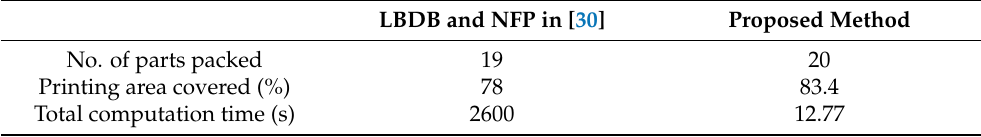
Table 4. Comparison between the LBDB and NFP method in the study in [30] and the proposed approach.